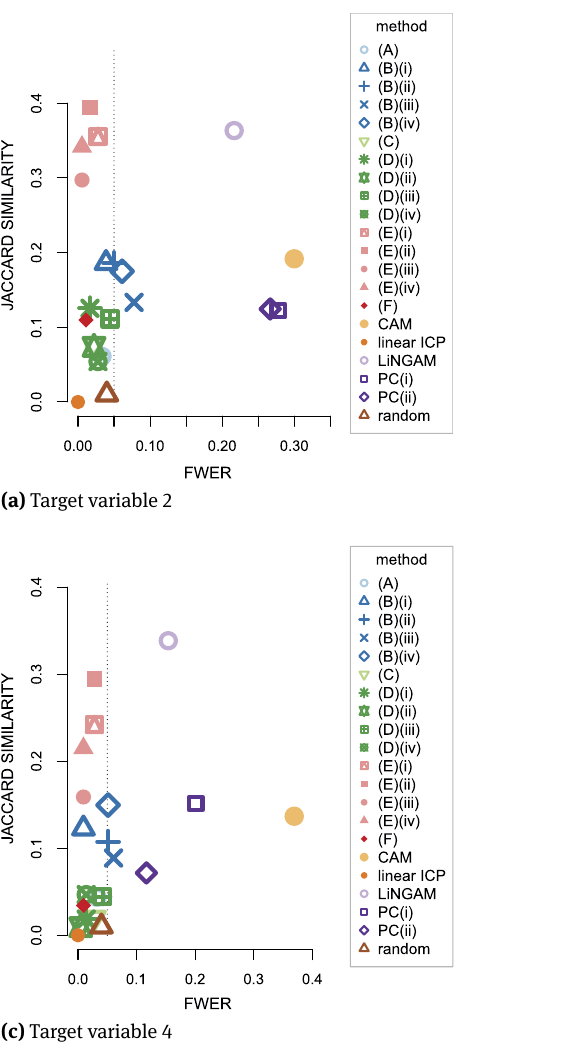
Figure 9: The identical plot to Figure 7 separately for target variables 2, 3, 4 and 6. For all target variables, method (E)(ii)—an invariant residual distribution test using GAM with Levene’s test + Wilcoxon test—performs constantly as good or nearly as good as the optimal method among the considered